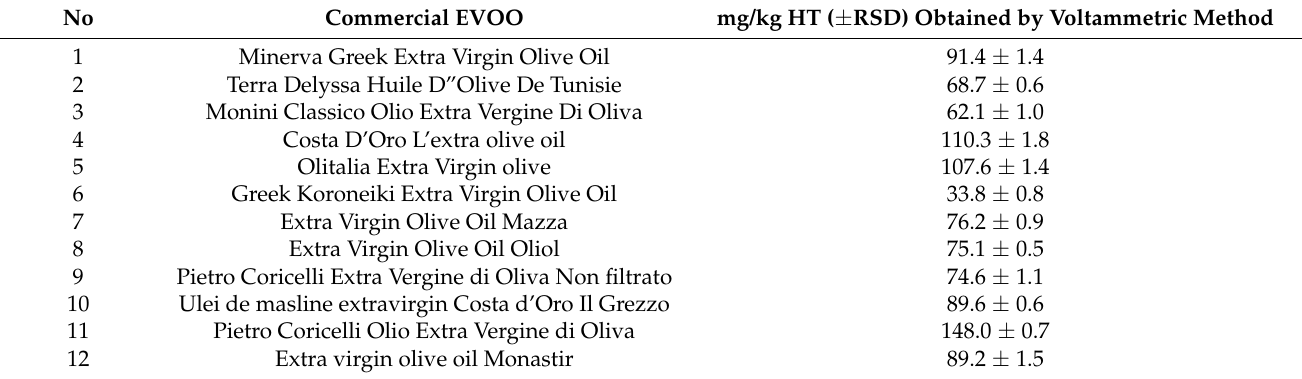
Figure 12. Cyclic voltammograms of the SPE-SWCNT-Ty biosensor immersed in samples of ( a ) Minerva Greek Extra Virgin Olive Oil, ( b ) Terra Delyssa Huile D”Olive De Tunisie, and ( c ) Monini Classico Olio Extra Vergine Di Oliva at a scan rate of 0.1 V×s − 1 . For quantification, the cathode peak intensity, corresponding to the potential − 0.003 V, was used for each product. The results are included in Table 6. Table 6. Concentrations of HT in commercial EVOO obtained by the voltammetric method.